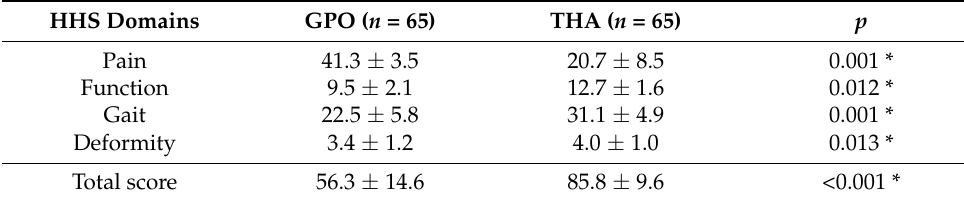
Table 3. Comparison of functional aspects by the pre-surgical baseline (GPO) and two-year post- operative Harris Hip Score (HHS) domains of total hip arthroplasty (THA) in older people with unilateral